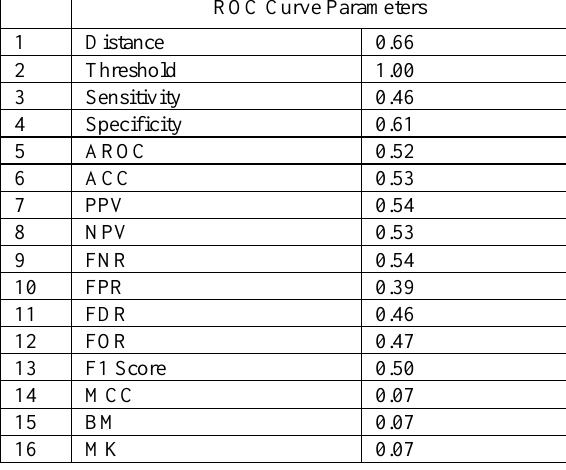
Table 4. Quantitative parameters of ROC where PPV and NPV are positive and negative predicted values, FNR and FPR are false negative and positive rates, FDR is false discovery rate, FOR is false omission rate, MCC is Matthews correlation coefficient, BM is In formedness and MK is